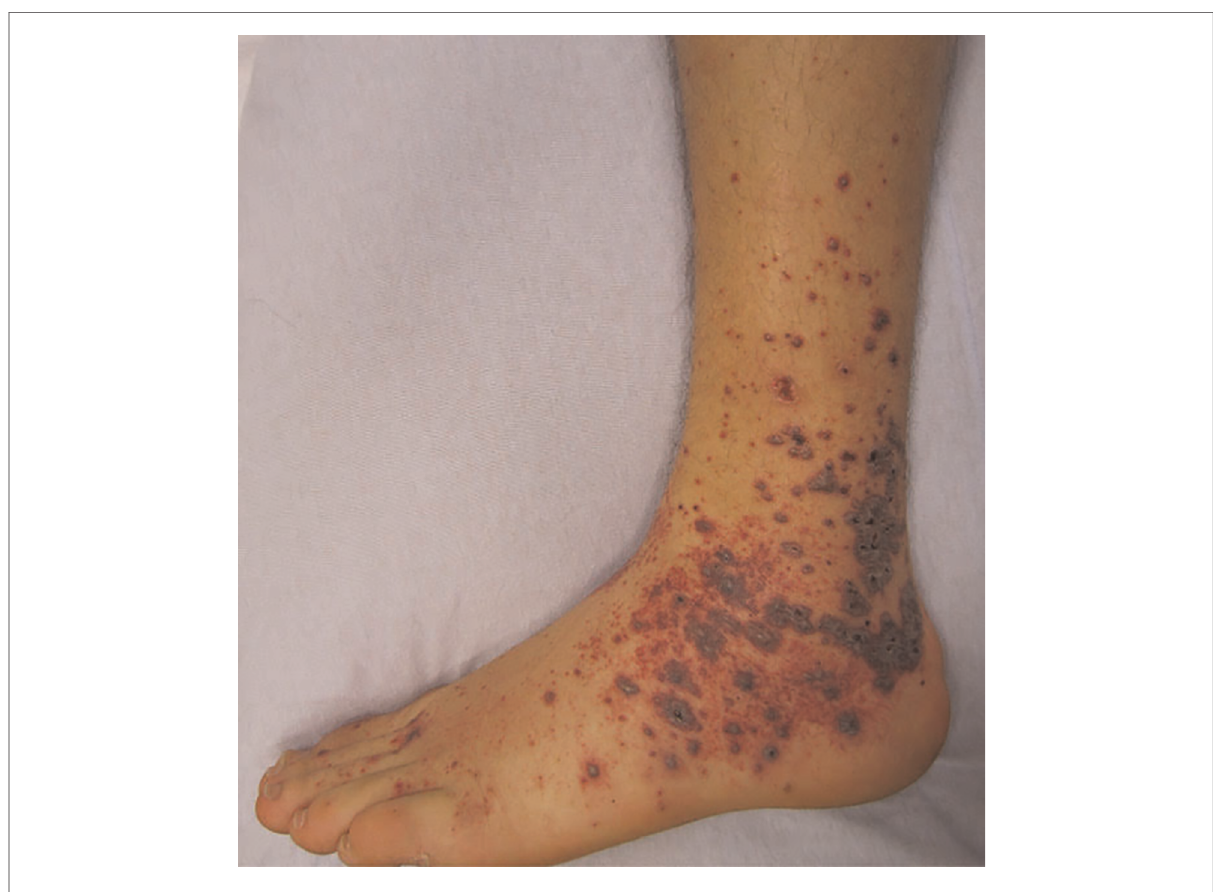
FIGURE 6 Purpuric/vasculitic